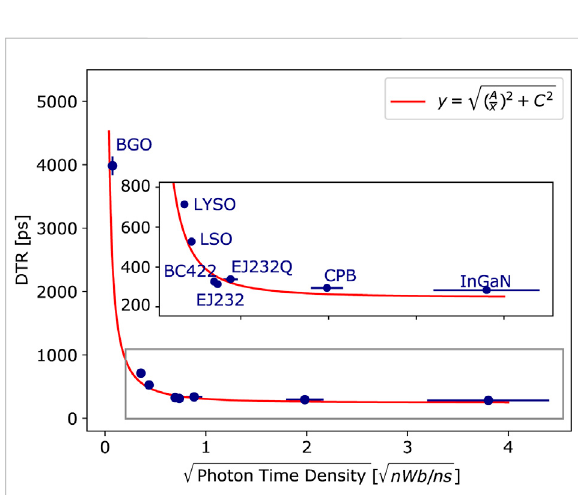
FIGURE 5 For all samples, the measured DTR is shown as a function of the square root of photon time density, de fi ned as the ratio between the mean collected charge and the effective decay time. The data were fi tted with the function y (cid:2) curve) to also take into account thesystem contribution ( C ).For all data, the error is represented for both the x -axis and y -axis, and when it is not visible, it means it is smaller than the point